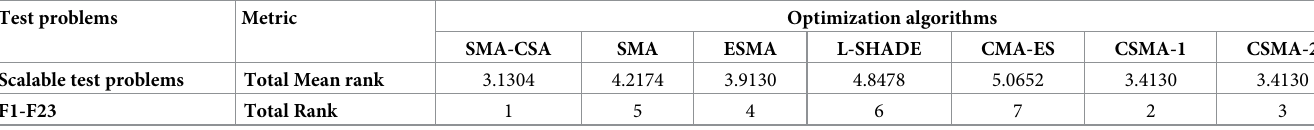
Table 11. Comparison results on Friedman’s ranking test with advanced algorithms.